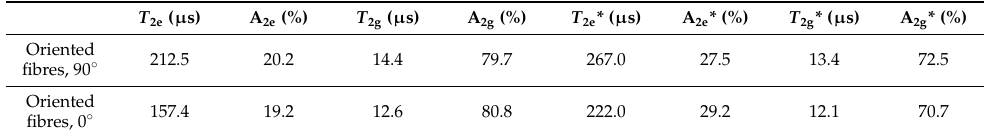
Table 5. NMR relaxation times ( T 2 ) of protons in oriented (0 ◦ and 90 ◦ ) silk fibres (untreated) and in silk fibres Bombyx mori after tensile loading. HL = 0.084. The data for silk with mechanical treatment are marked with (*). T 2e ( µ s)